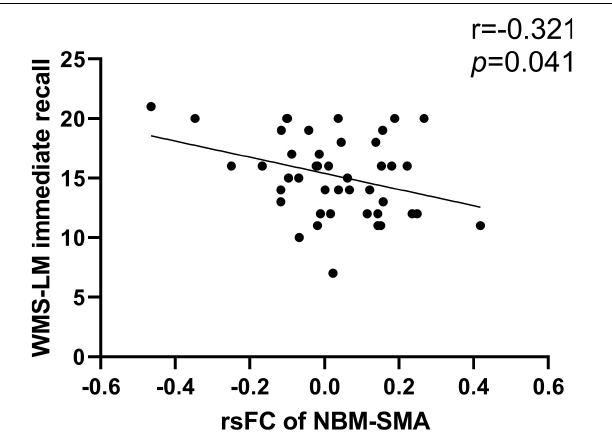
FIGURE 3 | Correlation between rsFC of the NBM and neuropsychological scores. The rsFC of left NBM to SMA was negatively correlated with WMS-LM immediate recall in smoking CN ( r = –0.321, p = 0.041). NBM, nucleus basalis of Meynert; SMA, supplementary motor area; WMS-LM, Wechsler Memory Scale-Logical